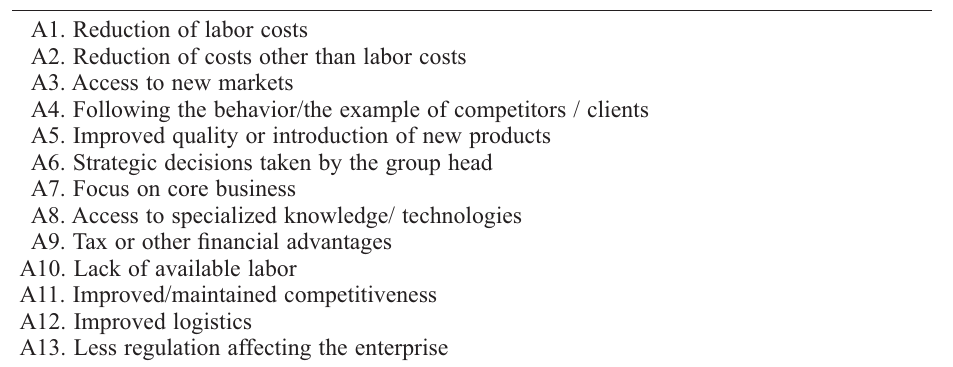
Table 1. Motivations for engaging in international